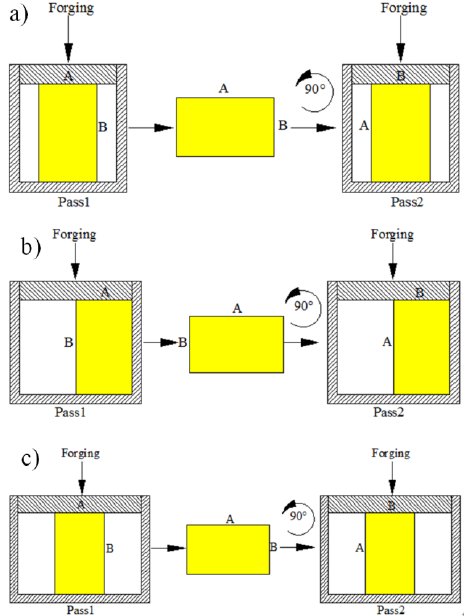
Figure 1. Schematic of three different multidirectional forging (MDF) processes: ( a ) Closed MDF (CMDF), ( b ) single-open MDF, and ( c ) double-open MDF.